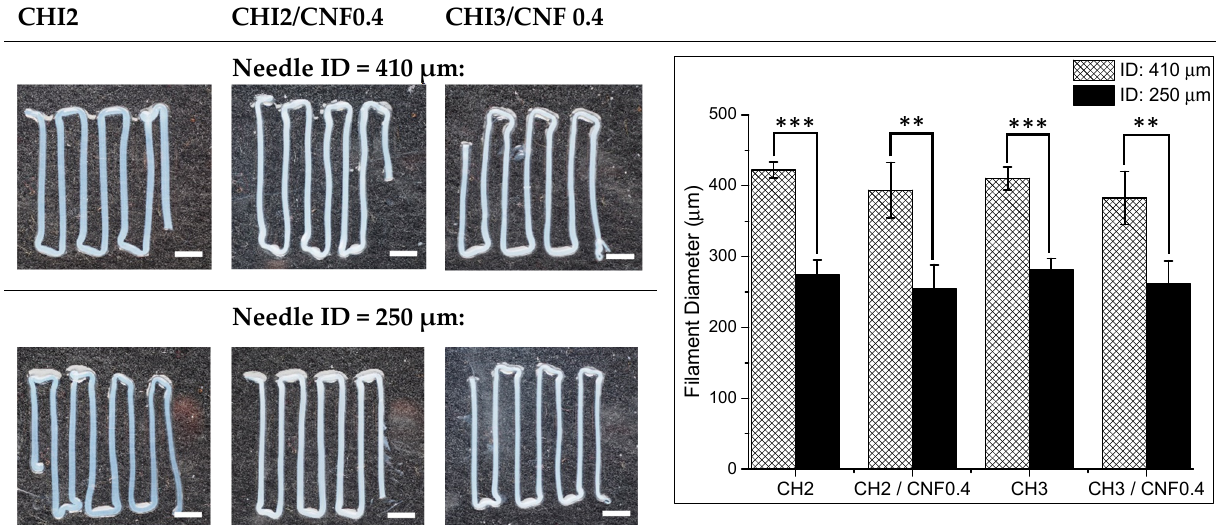
Figure 3. Photos of the hydrogel filaments obtained by microextruding CHI/CNF viscous suspensions of different compositions through needles with tip inner diameters (ID) of 250 or 410 µ m (scale bars: 1500 µ m). Histograms with hydrogel filament mean diameters obtained after printing the different CHI/CNF formulations. Right: Printed hydrogel average filament diameters obtained for the different CHI/CNF formulations, using the two different extrusion needle ID. For the statistical analysis, independent sample t -tests were performed with STATISTICA 10.0 (StatSoft Inc: Tulsa, OK, USA, 2011). p < 0.05 was accepted as statistically significant. Filament diameter values are expressed as means ± SDs. n = 6 (** p < 0.01, *** p < 0.001).